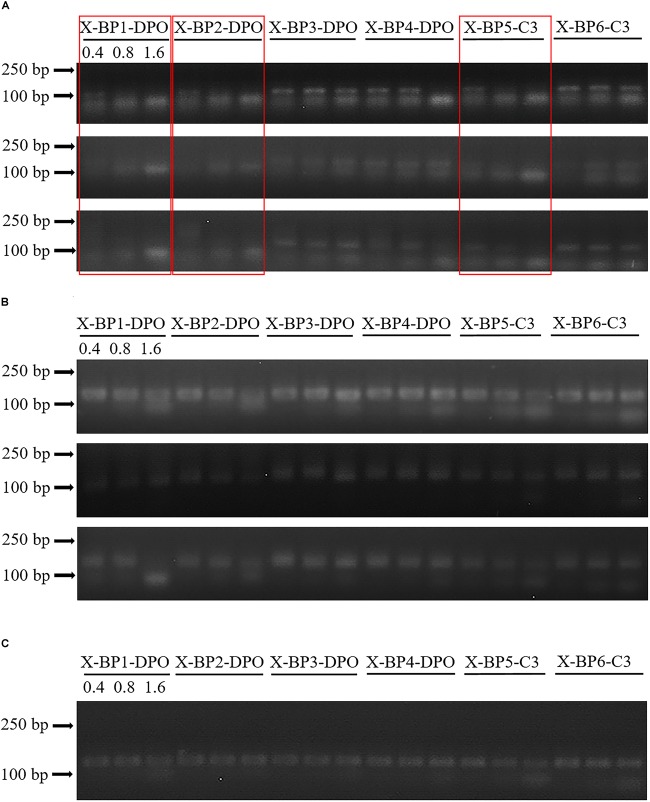
Inhibitory effects of blocking primers at varying concentrations against shrimp sequence amplification (A), eukaryotic microorganisms (B), zooplankton (C) templates. Samples were amplified with six different blocking primers against three shrimps at concentrations of 0.4, 0.8, and 1.6 μM. Experiments were repeated thrice. Primers (lanes) with preferred inhibition efficacy are marked with red rectangles. Please find the detailed methods of sample collection and PCR protocol from Sections “Sample Collection and DNA Extraction” and “Amplification With Blocking Primers” in the main text.